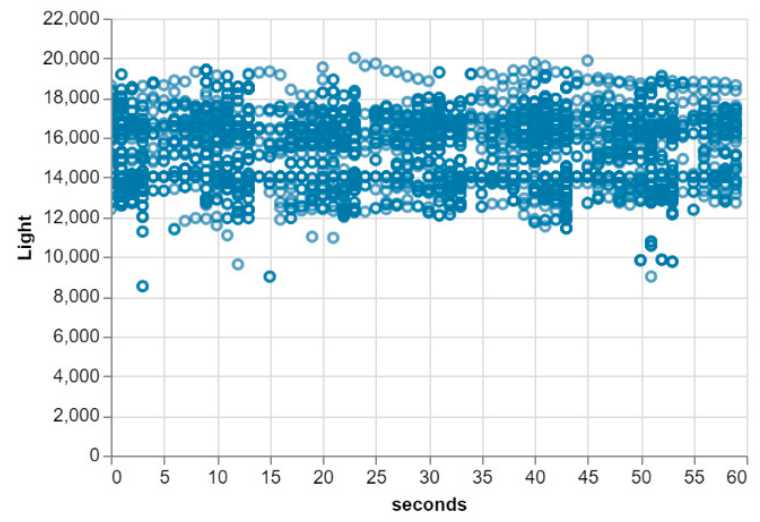
Figure 6. The ANN model dataset after moving the edge device (smartphone) to a new